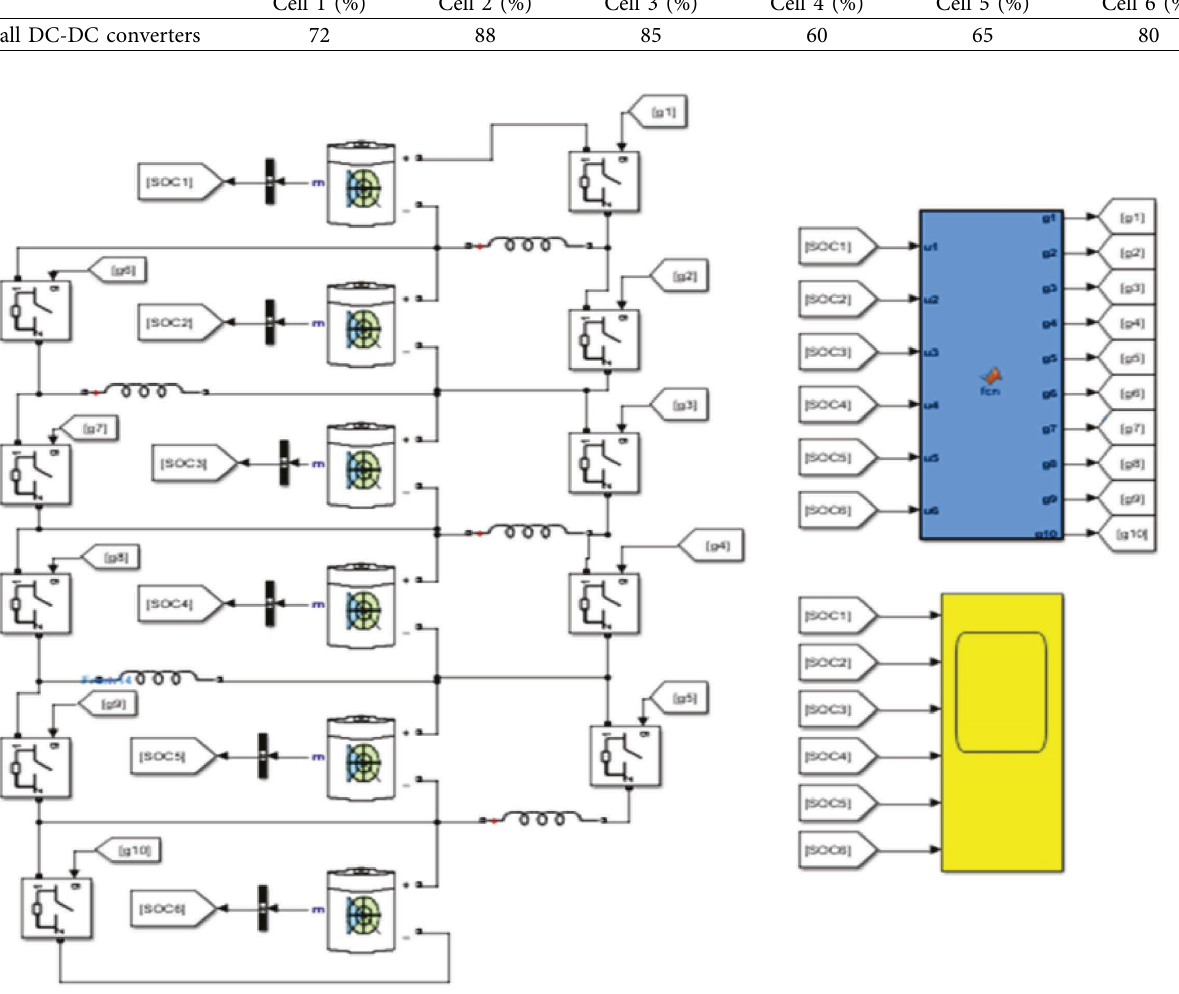
Figure 16: MATLAB simulink diagram of buck-boost converter-based BCE